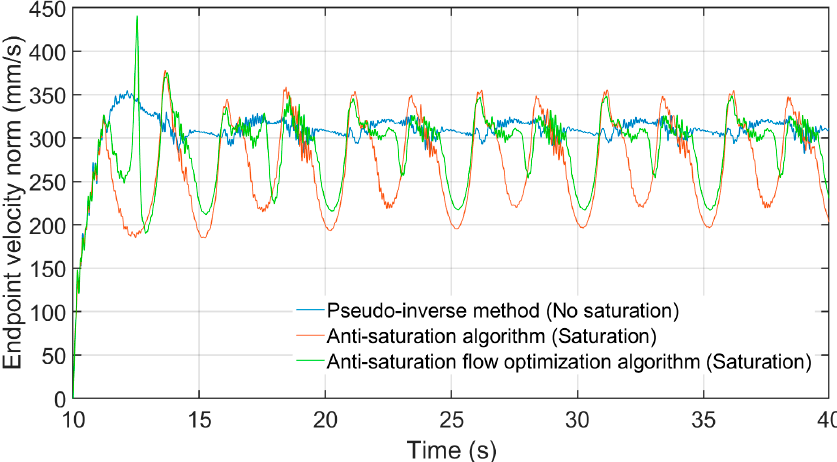
Figure 13. Comparison diagram of the endpoint velocity norm after mean filtering using three algorithms.